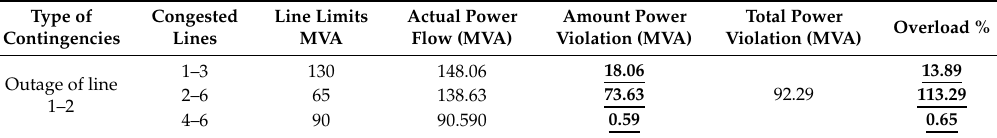
Table 2. Impact on network framework parameters due to outage of lines 1–2.